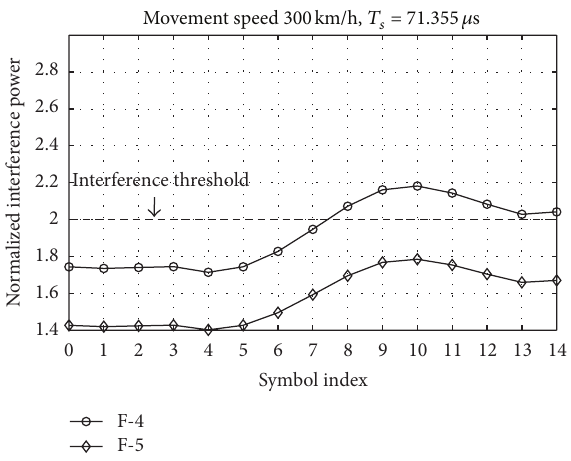
Figure 7: Mean interference power at the primary receiver.